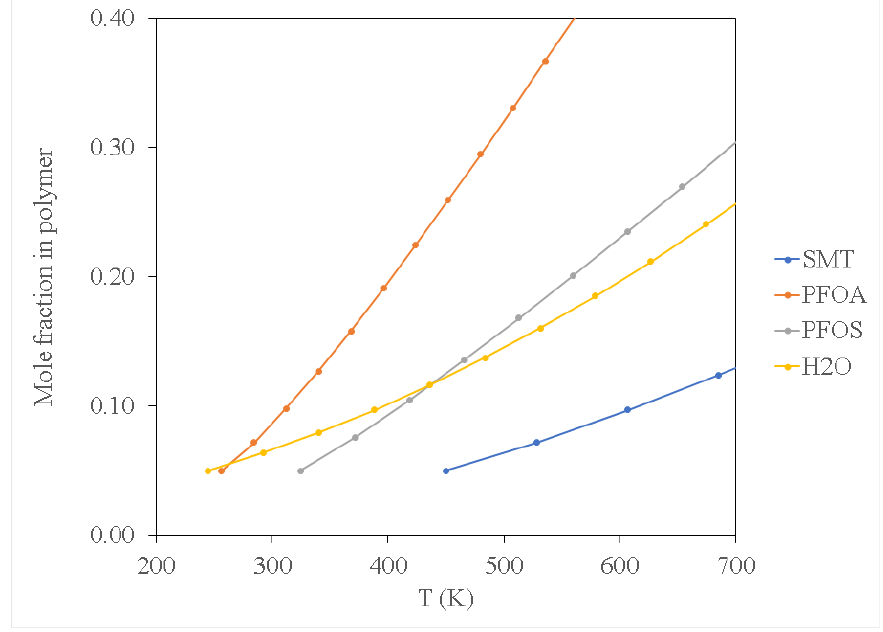
Figure 6. Effect of temperature on sorption in PE with respect to a fixed value of Np = 1000.